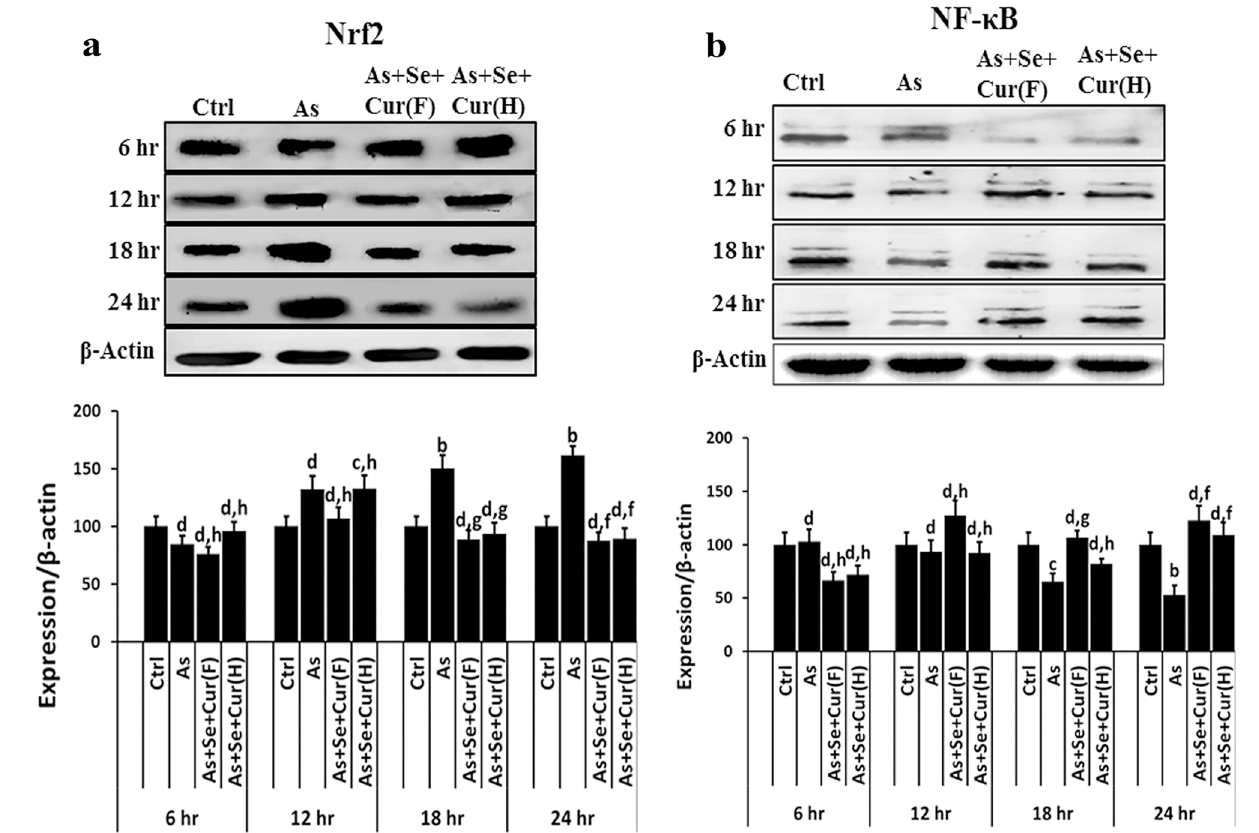
Fig 4. In utero exposure to iAs and/or additives induced changes in levels of (a) LRKs biomarkers, and (b) Nrf2 and NF-kB expression in neonate EpASCs. Data are mean of three different experiments; ± SEM, ‘ p ’ values are a < 0.001, b < 0.01, c < 0.05 and d > 0.05 vs. control and e < 0.001, f < 0.01, g < 0.05 and h > 0.05 vs.